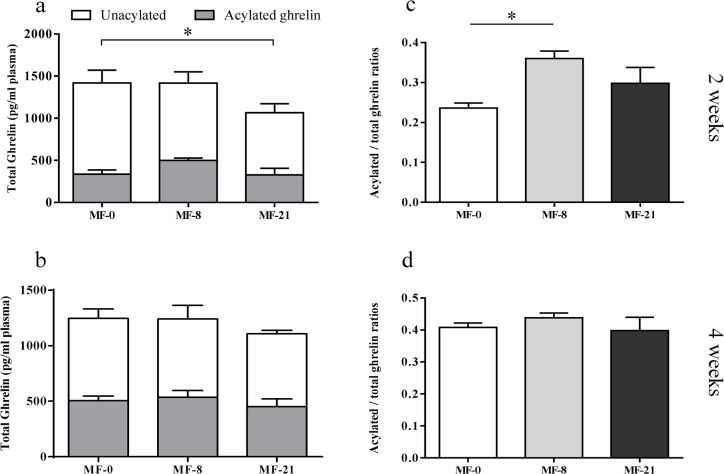
Effect of dietary tricaprylin level on the acylated and unacylated ghrelin concentrations, in the MF groups (fasted state).(a) Acylated and unacylated ghrelin concentrations after 2 weeks of diet. Kruskal-Wallis test (K-W): (i) acylated ghrelin, P = 0.0837; (ii) unacylated ghrelin, P = 0.038, Dunn’s post tests, *P<0.05; (iii) total ghrelin, P = 0.2345. (b) Acylated and unacylated ghrelin concentrations after 4 weeks of diet. K-W test: (i) acylated ghrelin, P = 0.4585; (ii) unacylated ghrelin, P = 0.5643; (iii) total ghrelin, P = 0.65. (c) Acylated/total ghrelin ratios after 2 weeks of diet. K-W test: P = 0.0181, Dunn’s post tests, *P<0.05. (d) Acylated/total ghrelin ratios after 4 weeks of diet. K-W test: P = 0.3635.